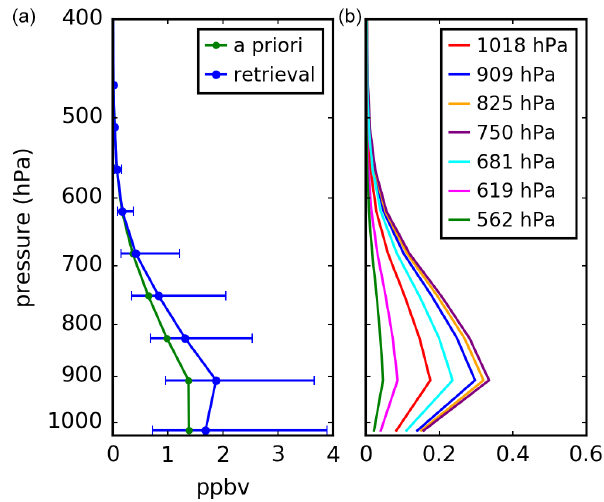
Figure 1. CrIS ammonia retrieval at 42.21 ◦ N, 70.82 ◦ W on 12 May 2016, 17:31:59UTC. Panel (a) shows the retrieval and a priori pro- files, while panel (b) shows the rows of the averaging kernel for the seven vertical levels closest to the surface. The number of degrees of freedom for this retrieval is